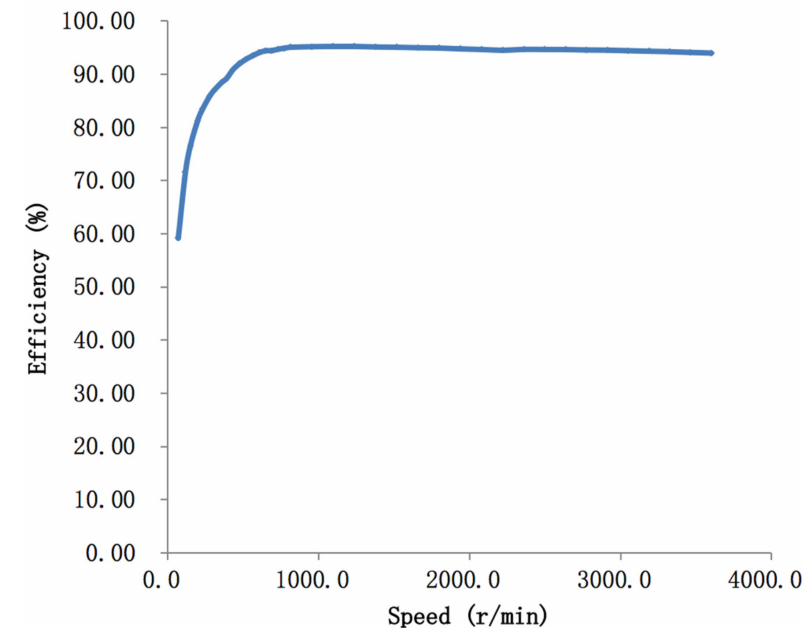
Figure 14. Driving efficiency of the